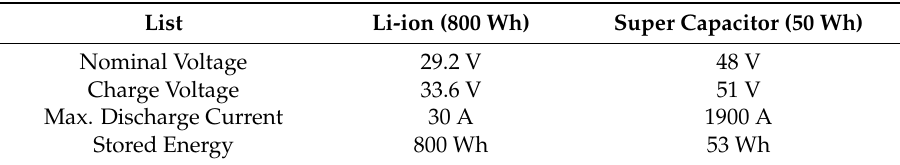
Table A1. LIB and SC